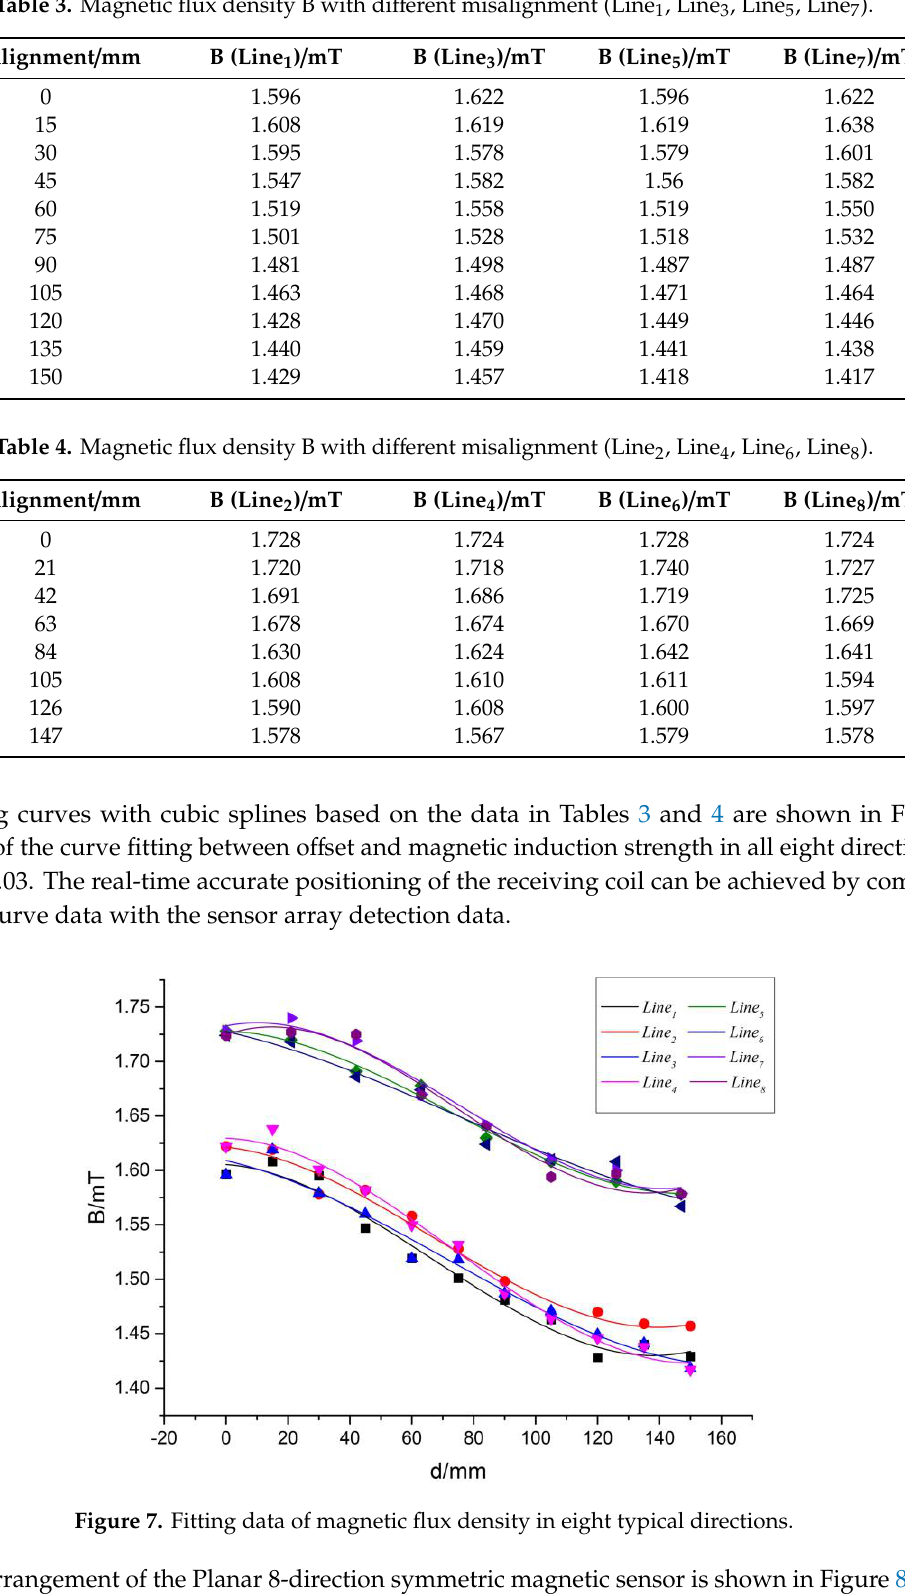
Table 3. Magnetic flux density B with di ff erent misalignment (Line 1 , Line 3 , Line 5 , Line 7 ).